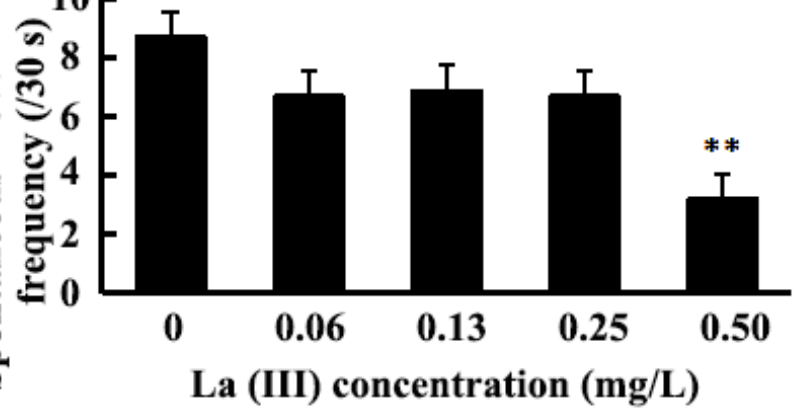
Figure 3. Effects of La (III) on spontaneous movement frequency of rare minnow embryos at 38 h. Error bars represent SD. ** Highly significant difference from the control group ( p < 0.01).